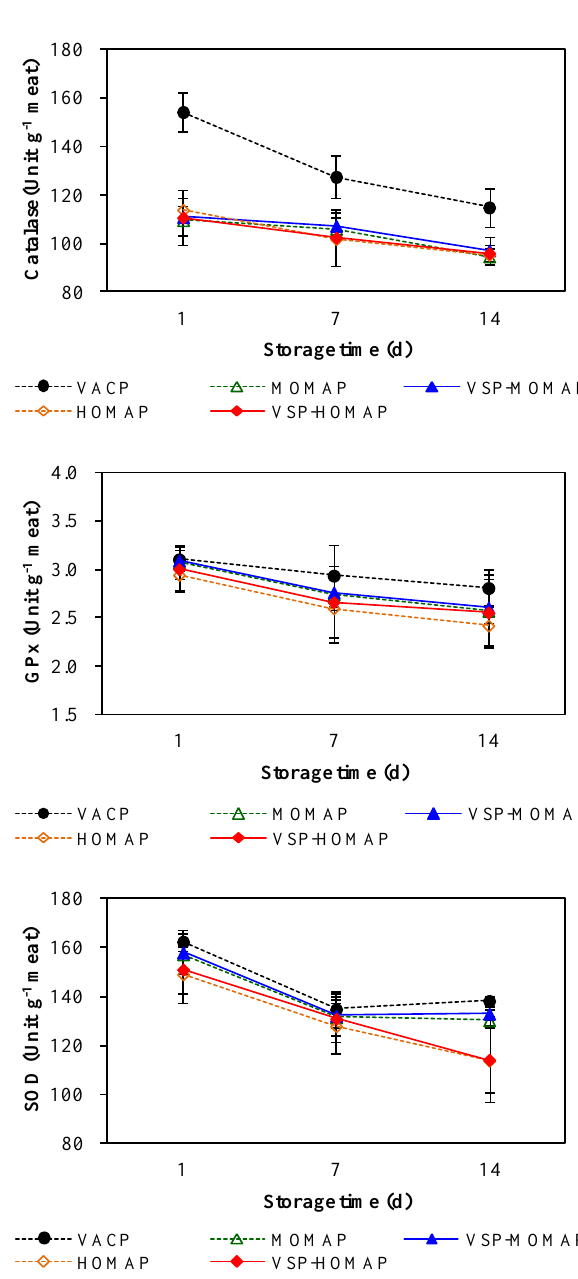
Figure 1. Antioxidant enzyme activity in sliced Hanwoo (Korean cattle) beef loin in various packaging systems for 14 d at 4°C. Data are presented as means±SD. GPx, glutathione peroxidase; SOD, superoxide dismutase; VACP, vacuum packaging; MOMAP, medium oxygen-modified atmosphere packaging (50% O 2 /20% CO 2 /30% N 2 ) alone; VSP-MOMAP, MOMAP combined with vacuum skin packaging; HOMAP, high oxygen-MAP (80% O 2 /20% CO 2 /0% N 2 ) alone; VSP-HOMAP, HOMAP combined with VSP; SD, standard